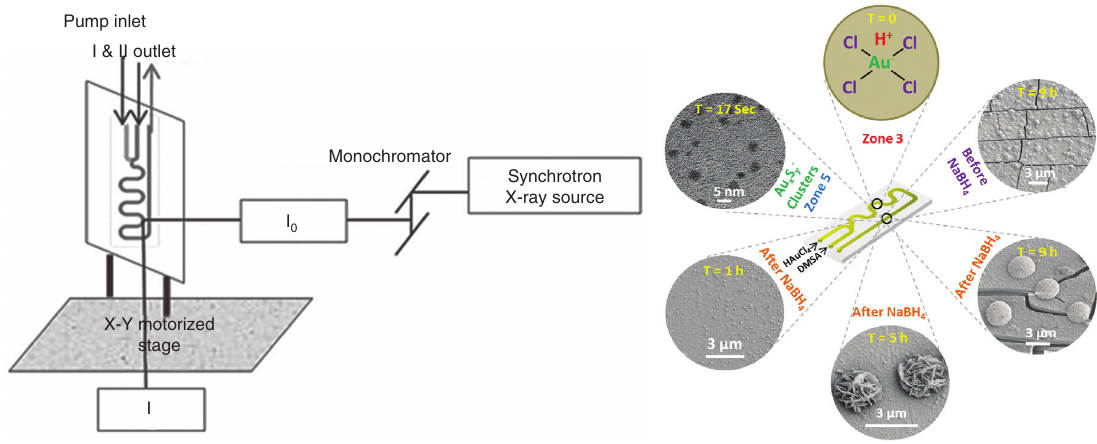
Figure 3 Novel in situ characterization tool utilizing millifluidics. Reprinted (adapted) with permission from [3]. Copyright (2013) American Chemical